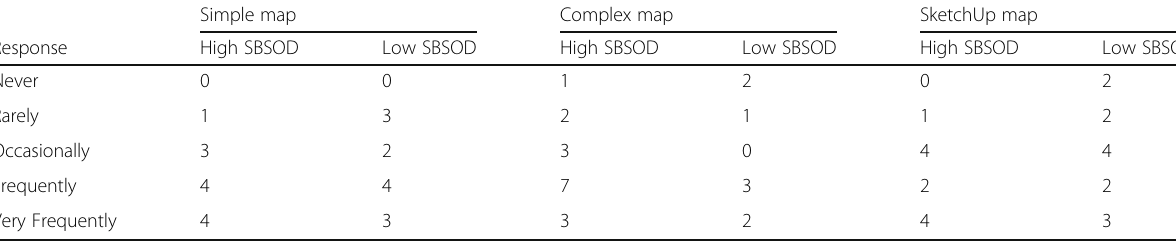
Table 2 Self-reported frequency of map usage during the route-learning task Simple